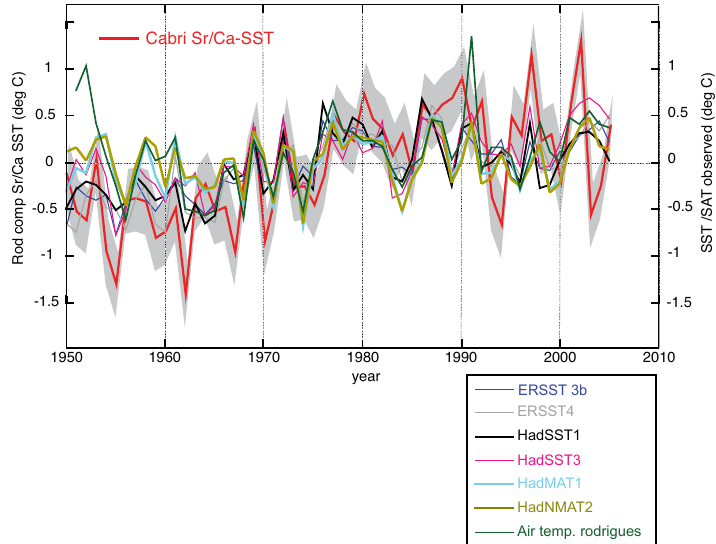
Figure 5. Time series of annual mean temperatures anomalies relative to the 1961–1990 mean for the coral Cabri SST reconstruction, Rodrigues weather station air temperature (AT), ERSSTv3b, ERSSTv4, HadISST, HadSST3, HadMAT1 and HadNMAT2 for the period 1950 to 2006. The uncertainty of mean annual coral Sr / Ca–SST anomalies is indicated by the grey